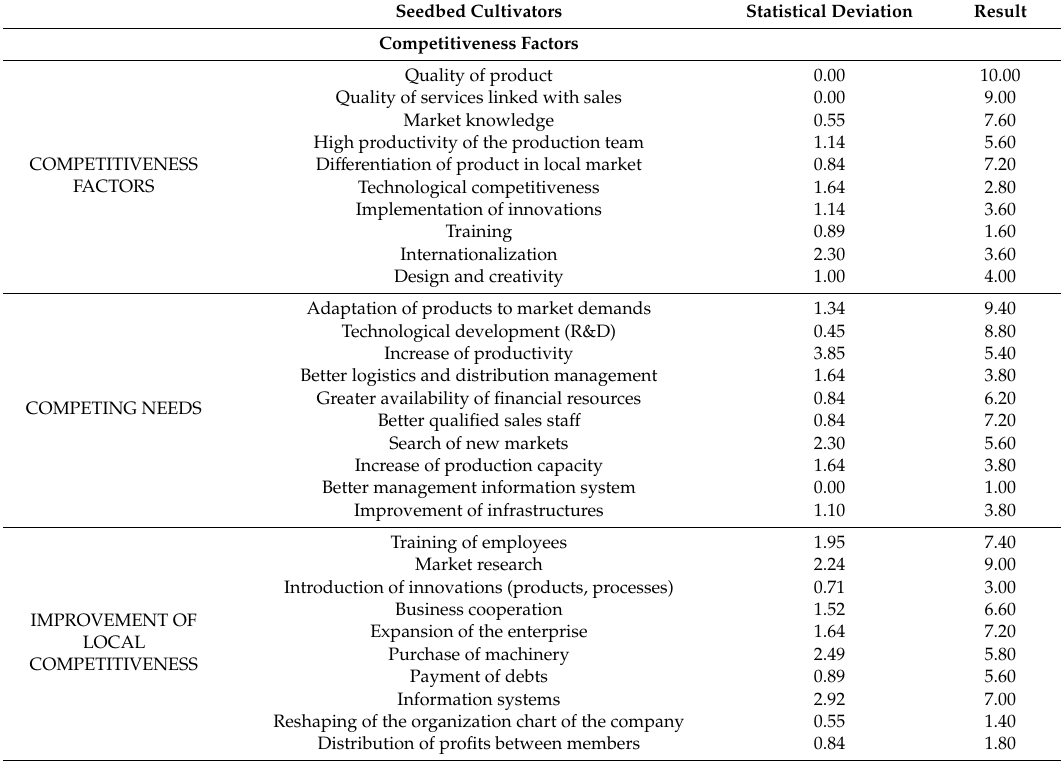
Table A4. Results and Statistical Deviation: Seedbed Cultivator